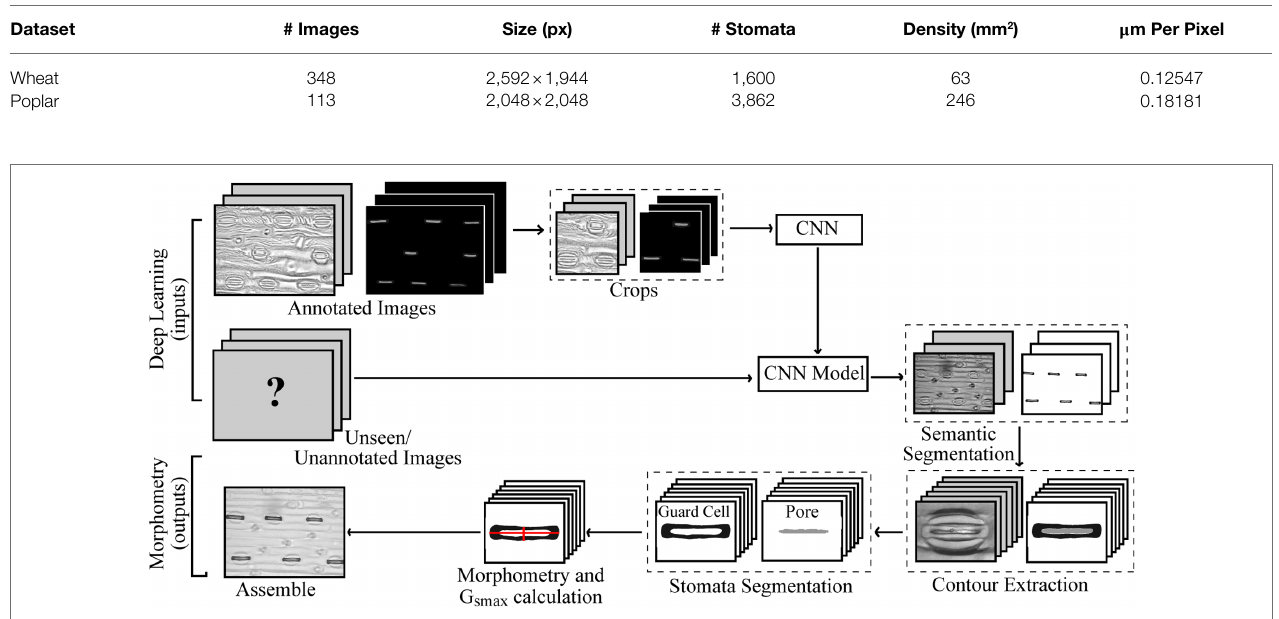
FIGURE 1 | Pipeline for the proposed method of extracted morphometric properties of stomata for the estimation of maximal stomatal conductance; anatomical g smax .